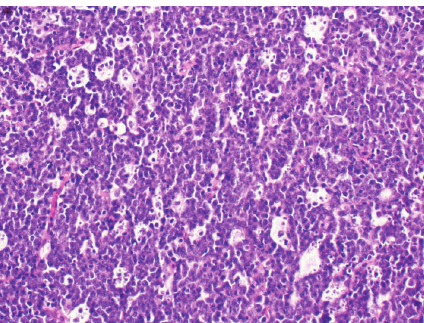
Figure 3: Tangible body macrophages dispersed among sheets of discohesive cells, giving the typical “starry sky” morphologic appearance (H & E stain, × 200 magnification).